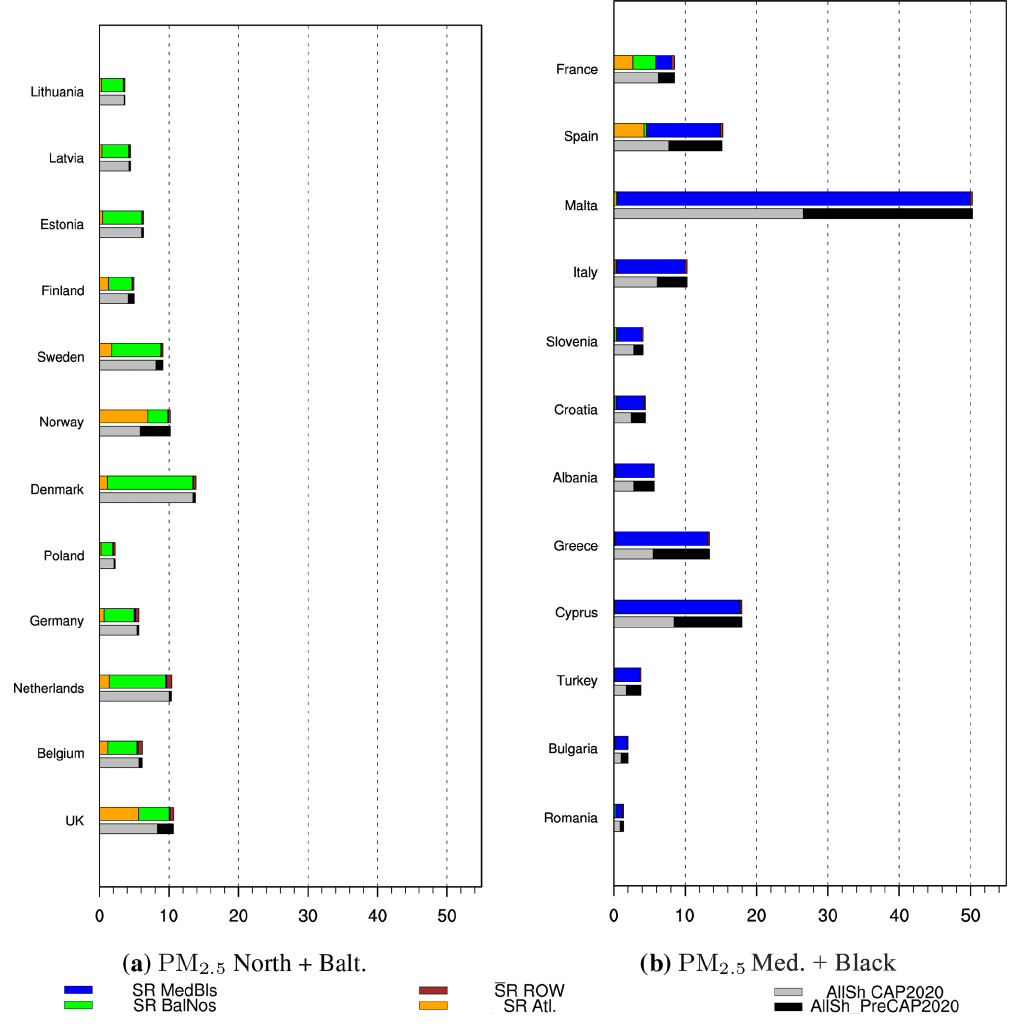
Figure 4. Percentage contributions from shipping to annually averaged PM 2 . 5 to countries bordering the North Sea and the Baltic Sea (a) and the Mediterranean Sea and the Black Sea (b) relative to contributions from all global anthropogenic emissions. Contributions are shown both for all ships and separated by sea area. For each country, the contributions from the individual sea areas are added in the upper bar and the contributions from all ship emissions calculated as the difference between the Base and SR_AllShips scenarios are shown as black + grey bar below. The Base − SR_AllShips bars are split in a black and grey part in which the first grey part represents the contributions after CAP2020, and black and grey represent the contributions prior to CAP2020. Differences in length between All ships (black and grey) and the added contributions from the separate sea areas are an indication of non-linear